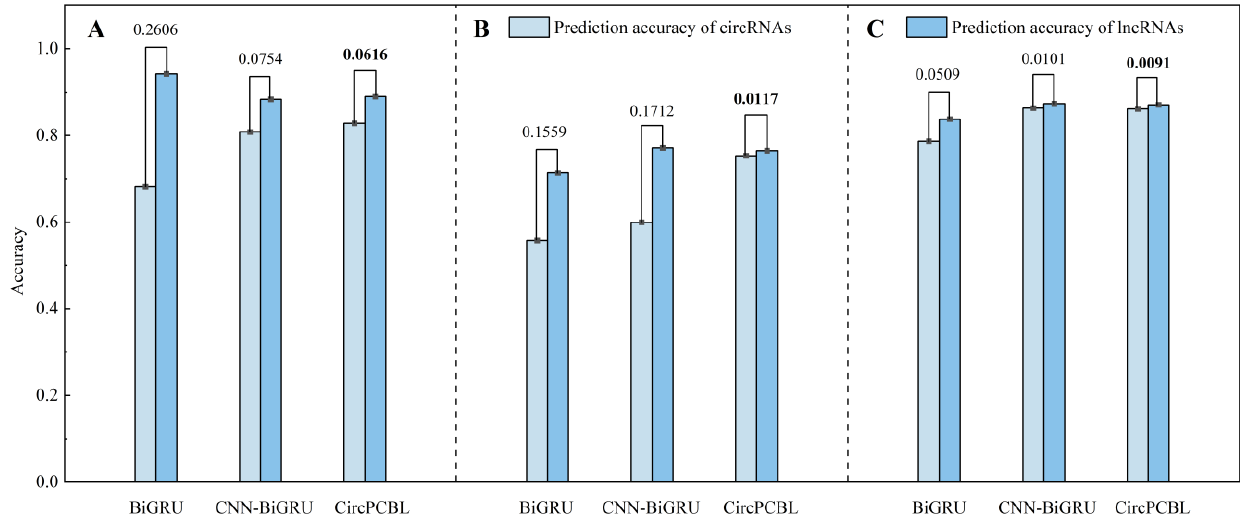
Figure 6. Single-class prediction accuracy with BiGRU, CNN-BiGRU, and CircPCBL models: ( A ) Cucumis sativus ; ( B ) Populus trichocarpa ; ( C ) Gossypium raimondii . The number on the bar chart indicates the prediction accuracy margin. Table 9. Performance comparison of CircPCBL on validation and independent test sets before and after SMOTE sampling. Dataset Model Accuracy Validation